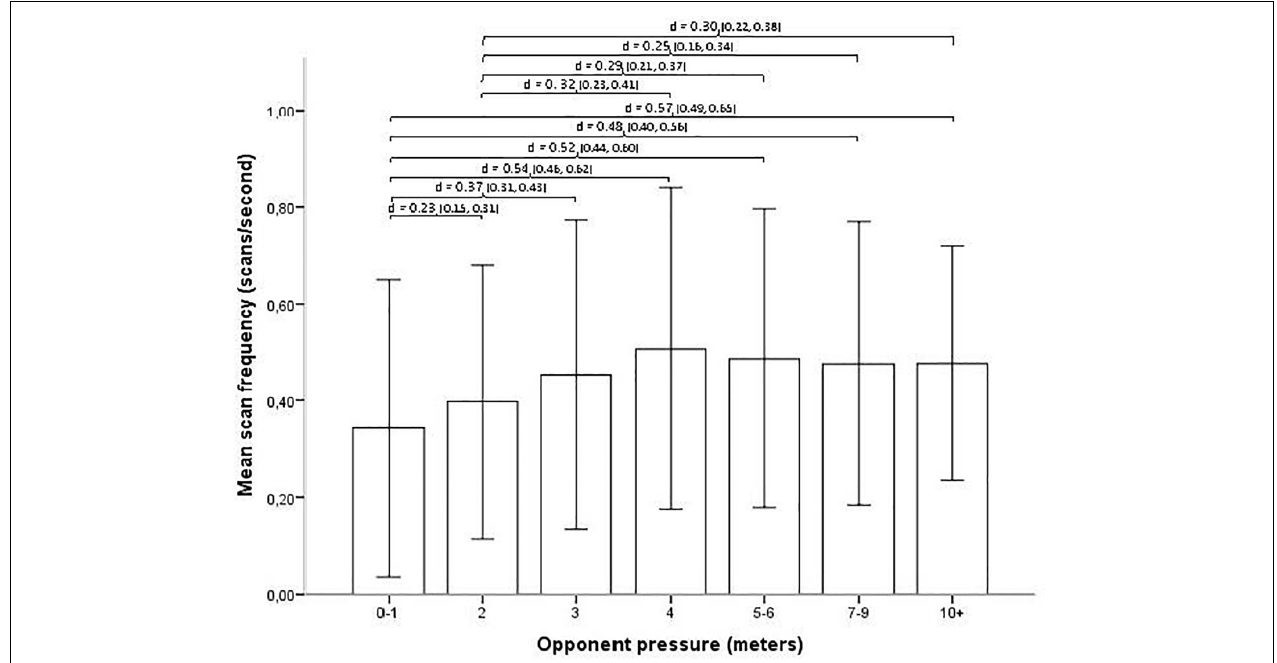
FIGURE 3 | Opponent pressure and mean scan frequency (with SD error bars). Brackets indicate all significant relationships with an effect size > 0.20, with effect size d and the 95% confidence interval (CI) in parentheses.